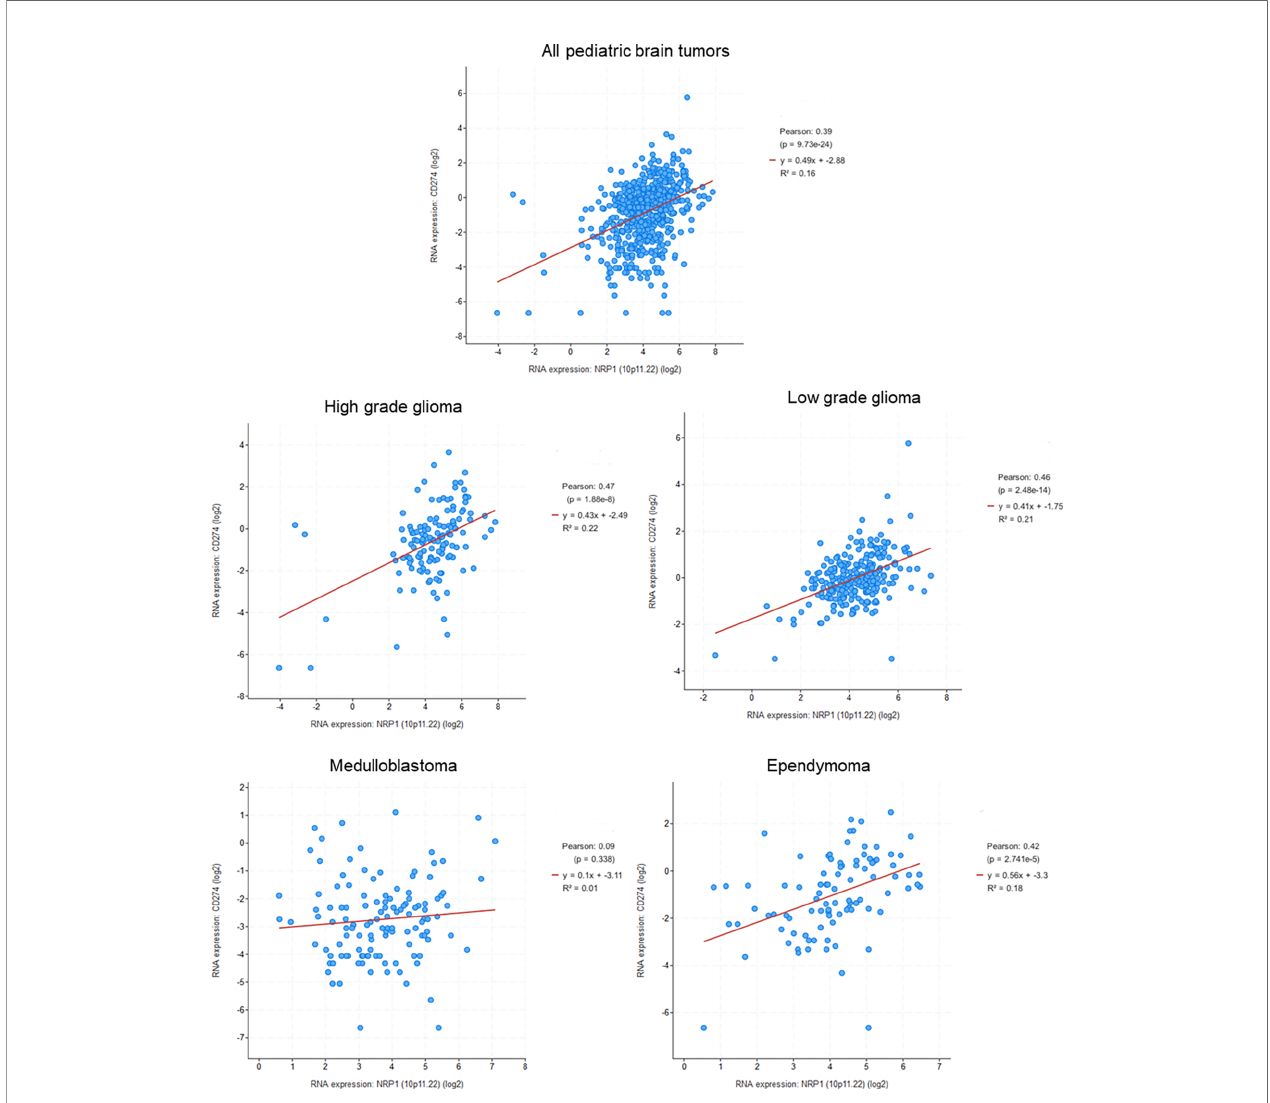
FIGURE 4 | Correlation between NRP1 and PDL1 (CD274) expression in pediatric brain tumors (Genomic characterization has obtained with cBioPortal provided by the Children ’ s Brain Tumor Tissue Consortium Database; Pediatric High Grade Gliomas: 133 samples; Pediatric Low Grade Gliomas: 261 samples; Medulloblastoma: 130 samples; Ependymomal Tumor: 97 samples). Pearson's correlation coef fi cient and corresponding p value were given for each tumor